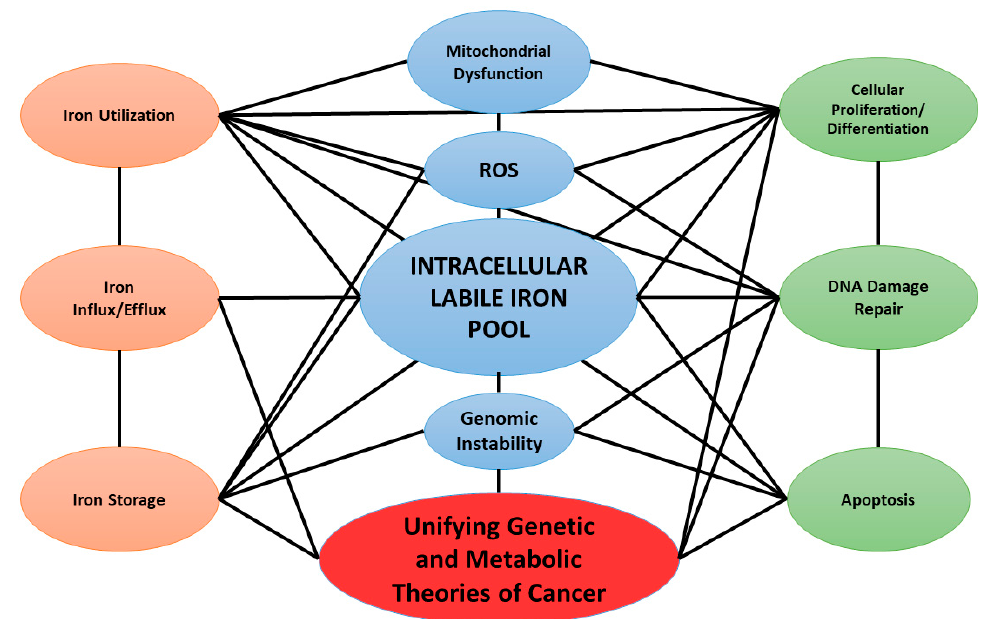
Figure 1. Simplified model of the network for intracellular iron regulation. This model unifies the genetic and metabolic theories of cancer where the intracellular labile iron pool (LIP) acts as a central hub in the genesis of cancer thereby linking iron metabolism to traditional hallmarks of cancer